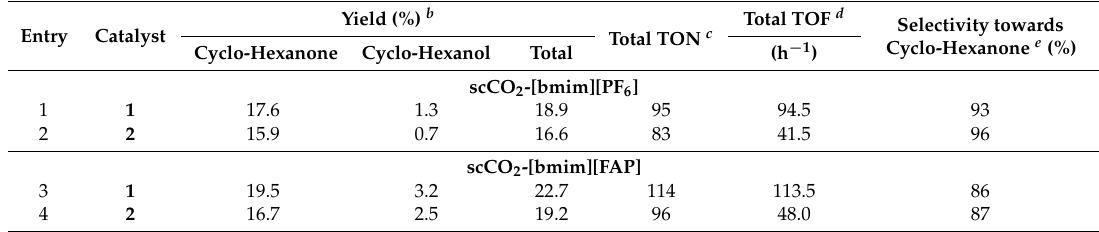
Table 3. Selected data a for the cyclohexane oxidation with TBHP in scCO 2 -IL